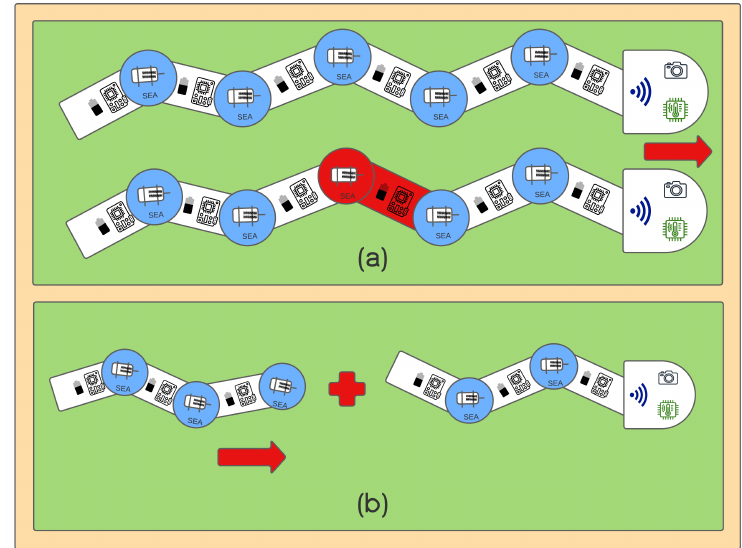
Figure 4. Illustrating the benefits of the modular design of the snake robot. This makes it possible to: ( a ) achieve locomotion even in the event of a module failure; ( b ) modular reconfiguration (self- assembly) of the snake